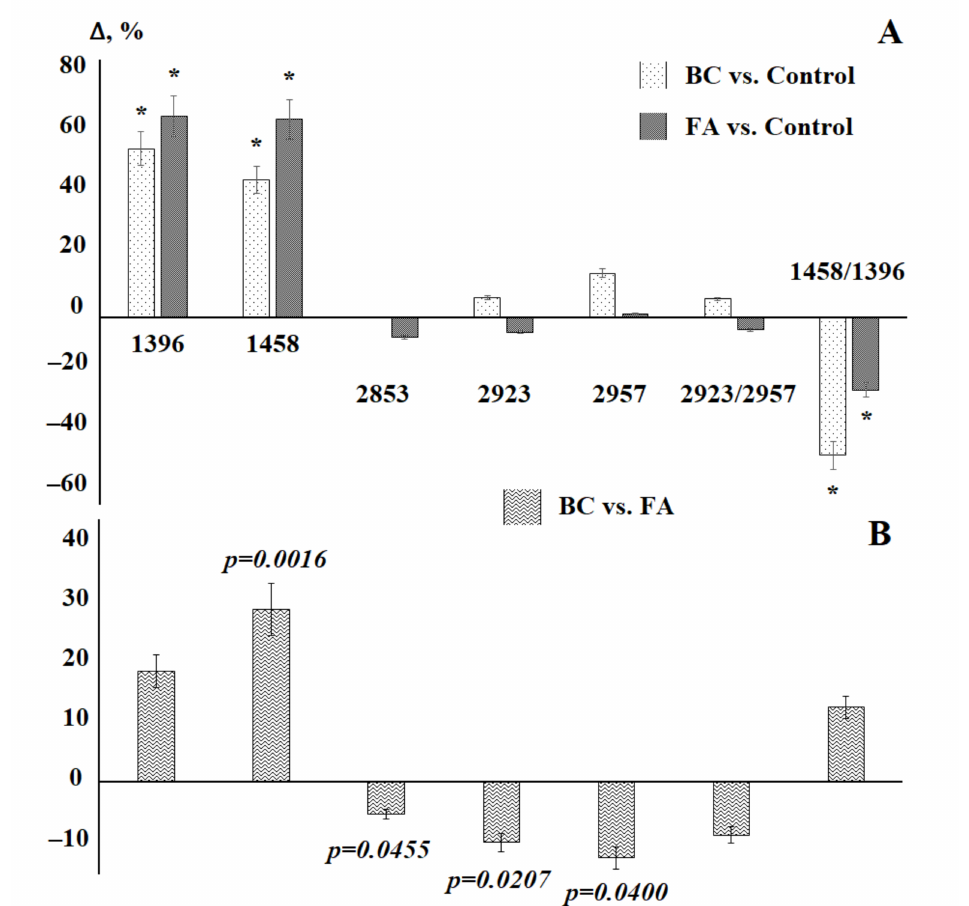
Figure 4. Changes in the intensity of absorption bands on the IR spectra of saliva in patients with breast cancer (BC) and fibroadenomas (FA) compared with the control group ( A ) and patients with breast cancer compared with fibroadenomas ( B ). *—differences are statistically significant, p < 0.05. p -values are calculated using the paired Mann–Whitney